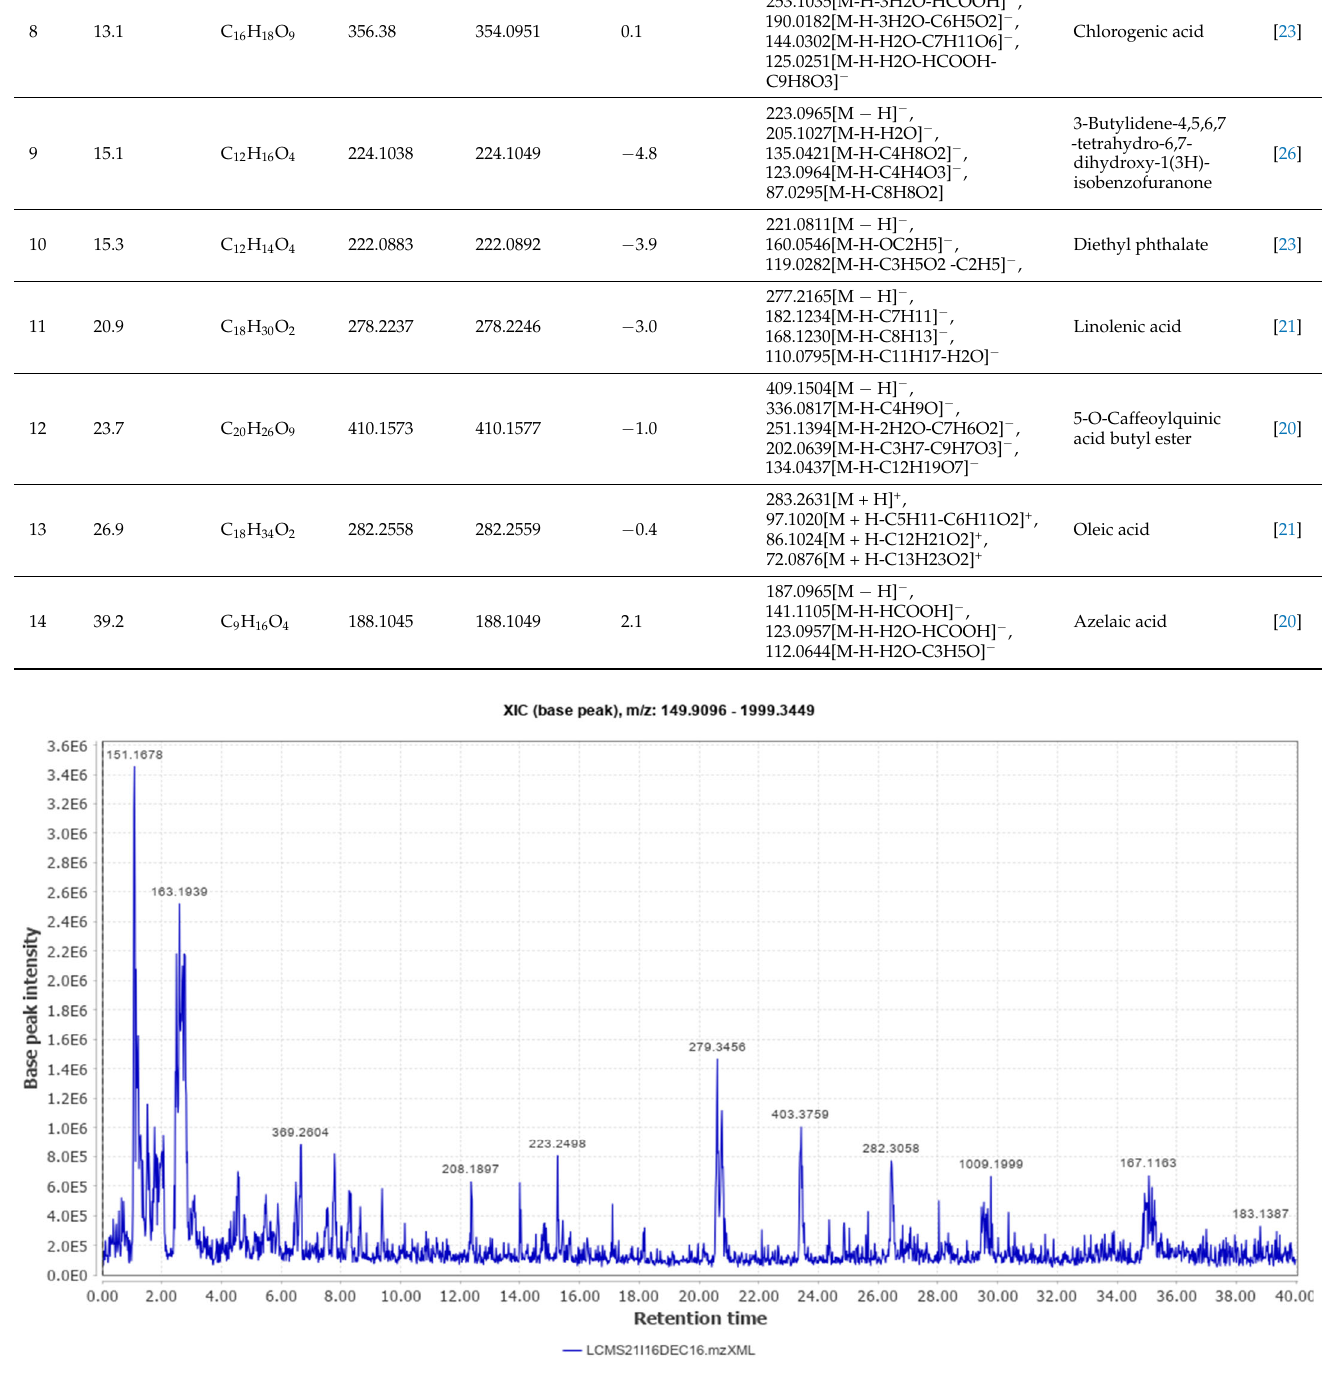
Figure 1. Total Ion Chromatogram (Positive Mode).